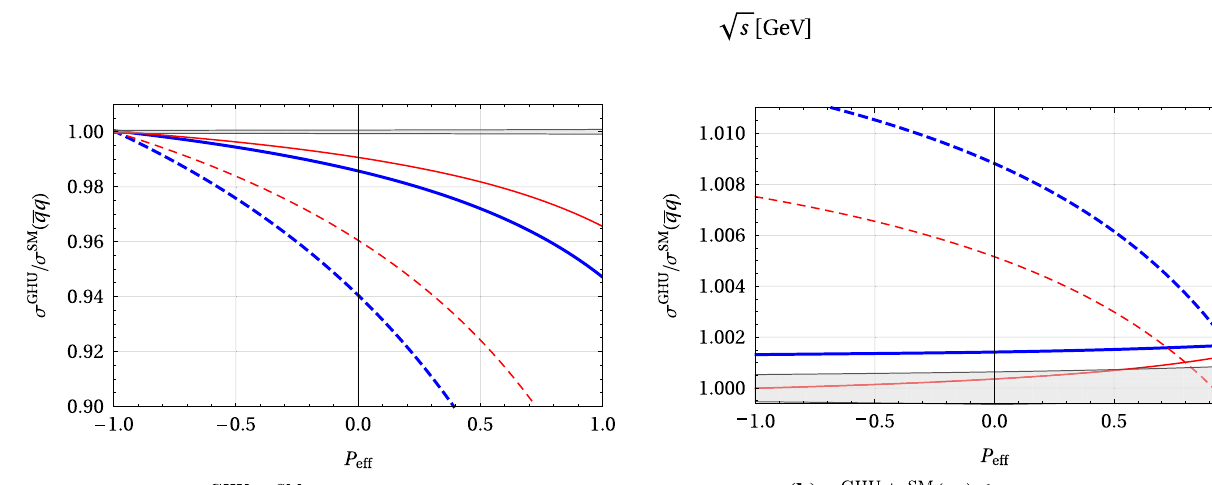
Fig. 1 Cross sections of the e + e − → ¯ qq ( q (cid:14)= b , t ) process with unpolarised beams in the SM and GHU model for θ = 0 . 10. Black solid line H represents the cross sections in the SM. Green dashed and purple dotted lines correspond to that in GHU model with c q > 0 and c q < 0, respectively